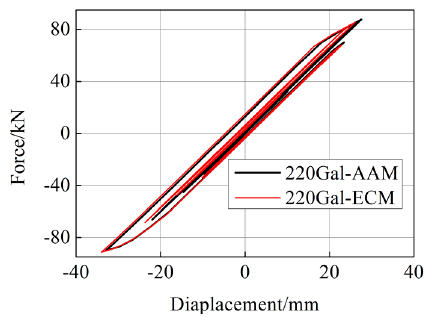
Figure 12. Hysteretic loops of numerical column (220 Gal).